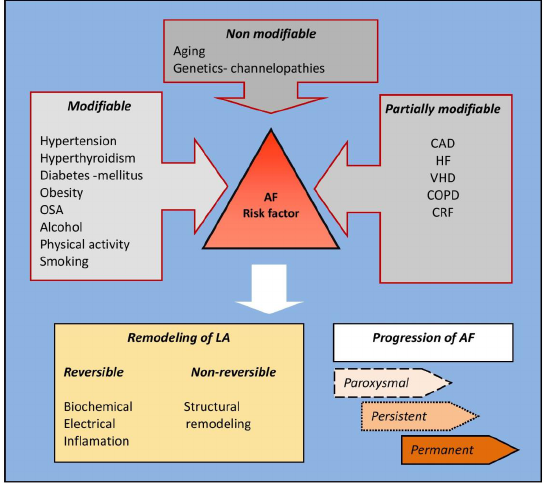
Figure 1. Cardiovascular risk factors for the development of AF [1]: Legend: AF — atrial fibrillation; CAD — coronary artery disease; COPD — chronic obstructive pulmonary disease; LA — left antrum; OSA — obstructive sleep apnea; HF — heart failure; VHD — valvular heart disease; CRF — chronic renal failure.